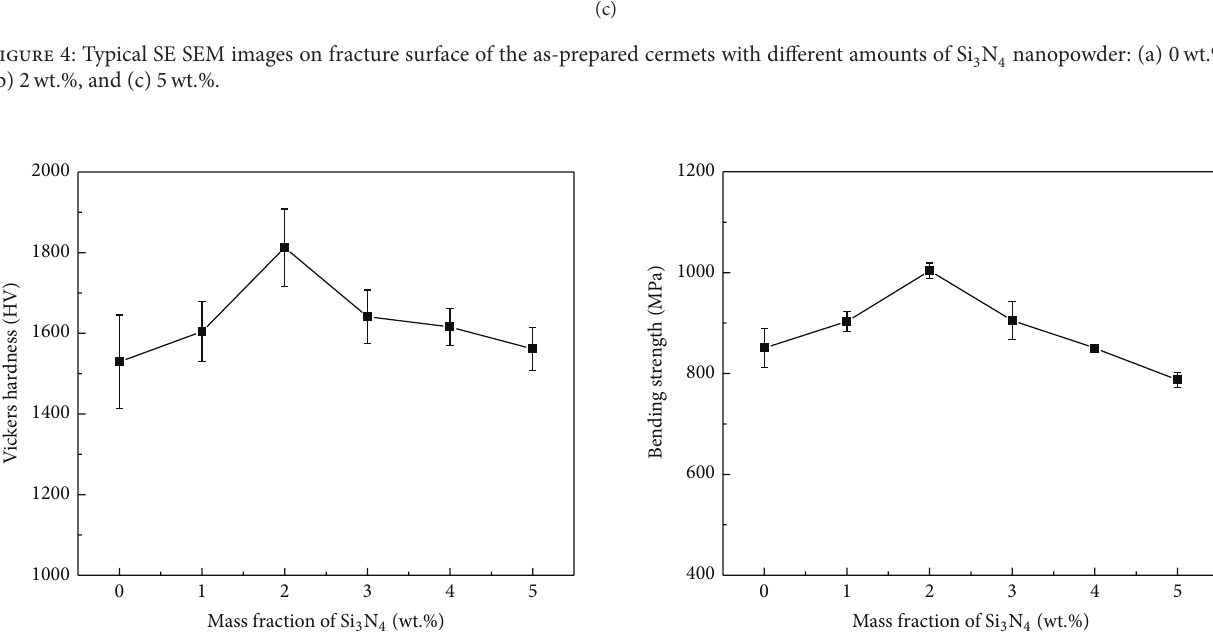
Figure 5: Vickers hardness of the as-prepared TiCN-based cermets as a function of mass fraction of Si 3 N 4 nanopowder.